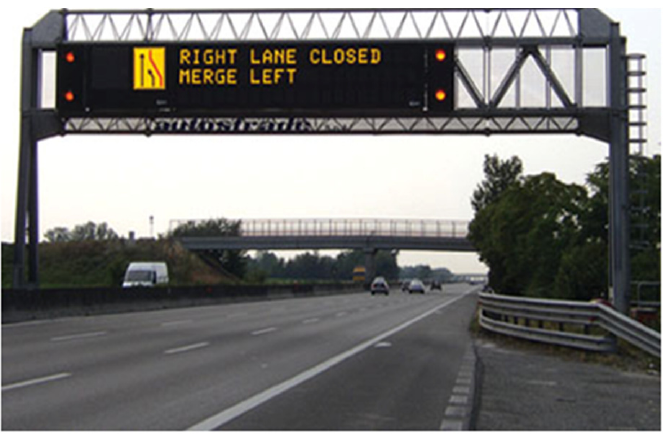
Figure 15. Variable-message sign.